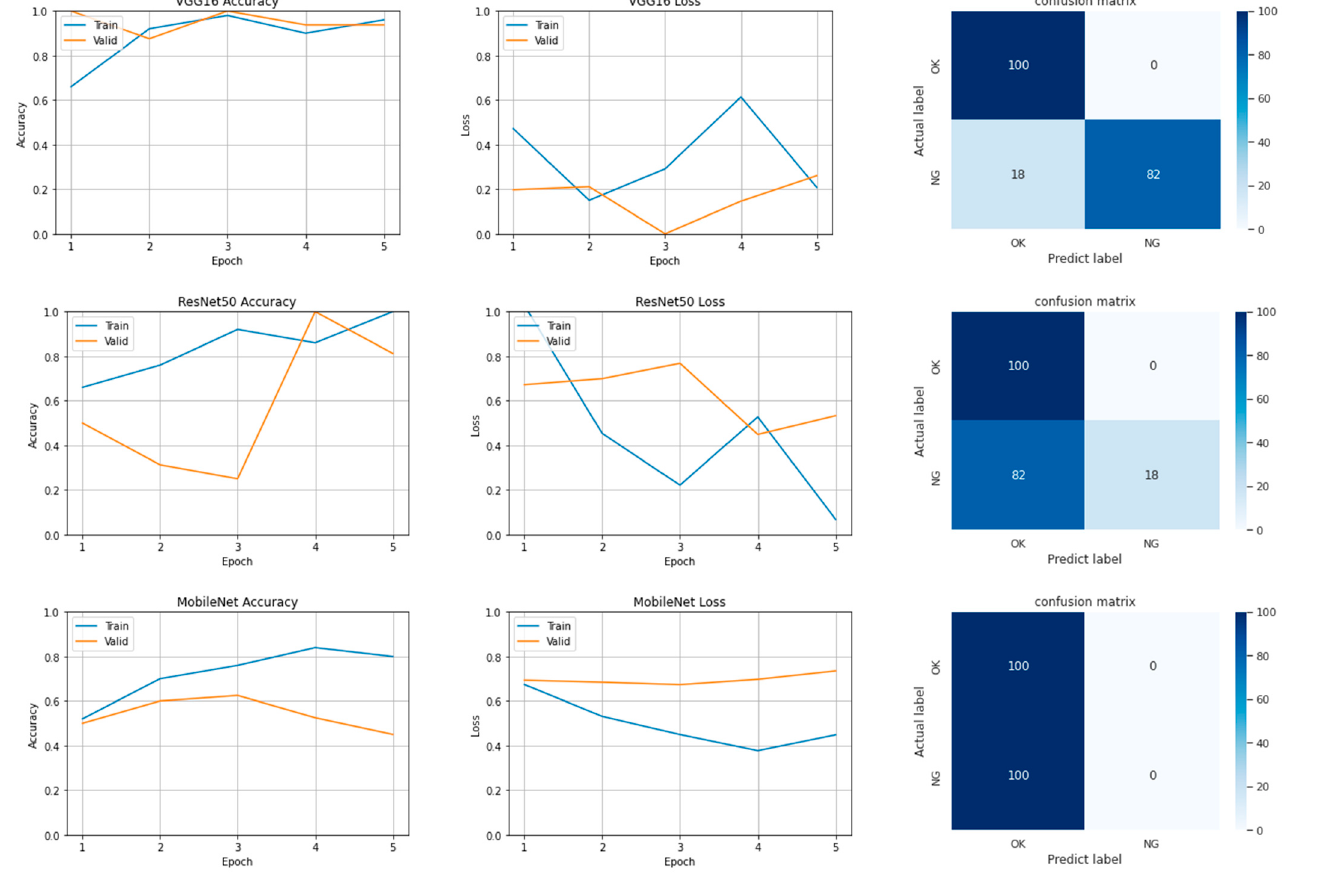
Figure 13. Accuracy and loss in training and validation and confusion matrix for each tested model.